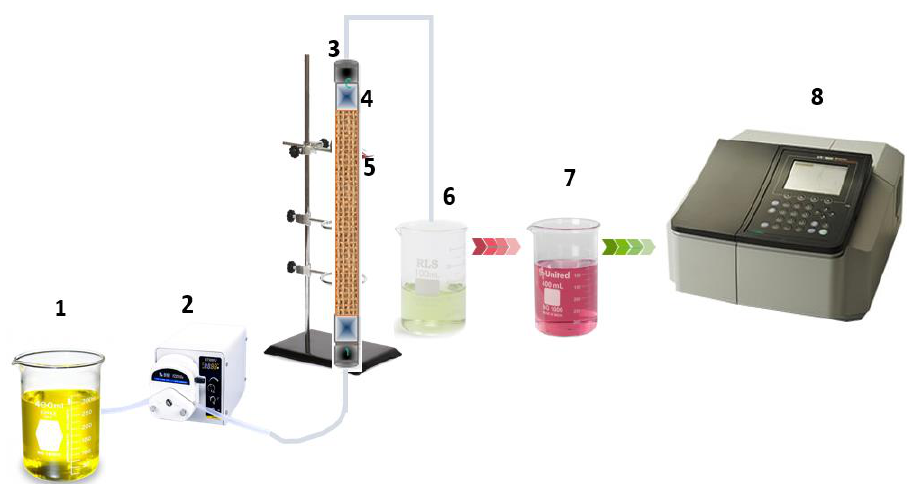
Figure 1. Schema of the experimental setup for the Cr(VI) fixed-bed adsorption. 1 — Cr(VI) solution reservoir, 2 — Peristaltic pump, 3 — Cotton plugs, 4 — Glass ball, 5 — RPS fixed bed, 6 — taken sample of Cr(VI), 7 — Ready sample for analysis, 8 — Spectrophotometer UV-Visible .